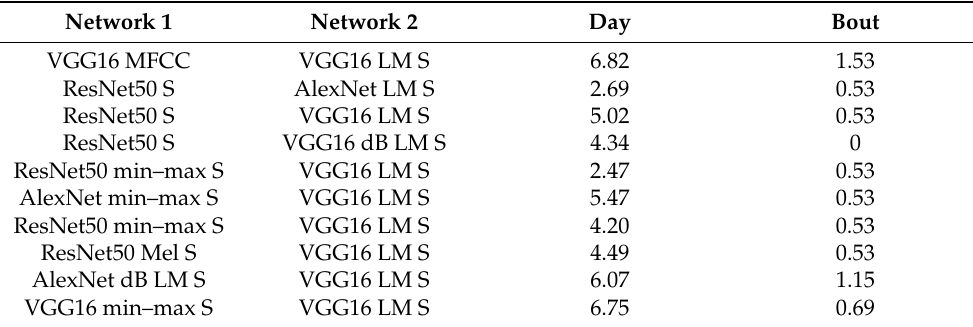
Table 5. Equal Error Rate (EER) of Best Performing 2-Ensemble on the EER Day and EER Bout Datasets (sorted by performance).